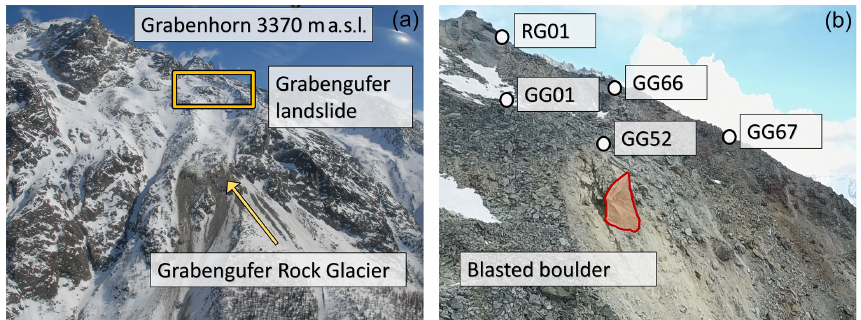
Figure B1. The Grabengufer rock glacier in winter. Panel (a) shows an overview of the catchment with the Grabenhorn on top, the Graben- gufer landslide, and the Grabengufer rock glacier above the Dorfbächji channel, with exposed eroded debris. Panel (b) shows the zoomed-in area highlighted with the yellow box, the Grabengufer landslide in summer. The different measurement positions, the reference station, and the freestanding block (approx. 2000m 3 ) blasted in summer of 2018 are labelled. Photos from PermaSense archive.